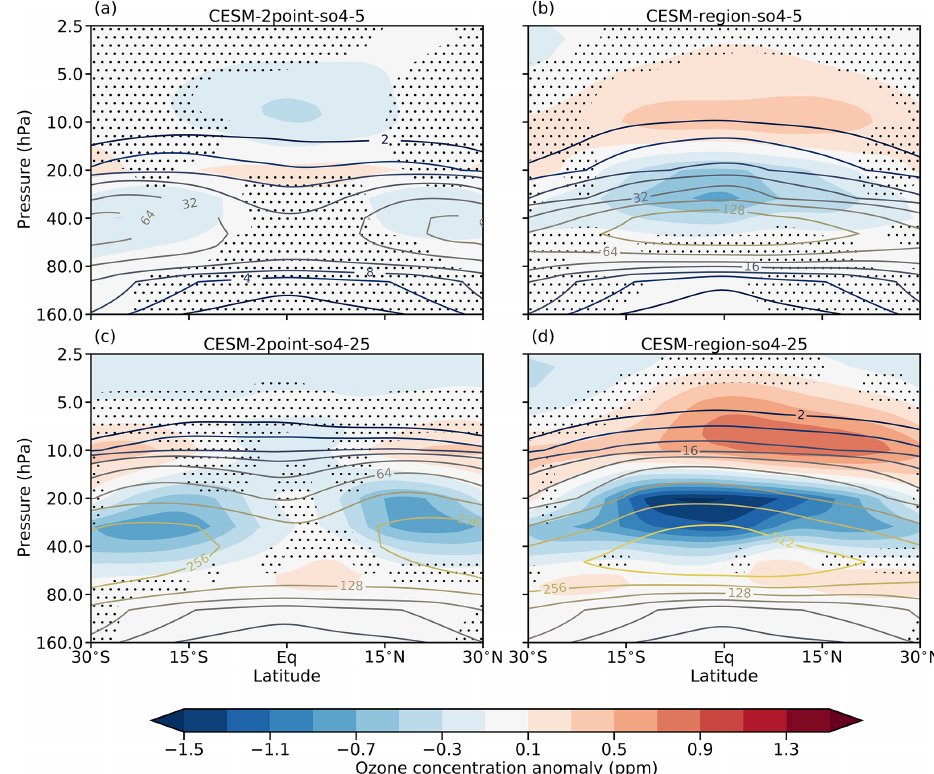
Figure 15. Latitude–height cross section of the ozone concentration anomaly for the simulations of an AM − SO 4 injection in CESM. Stippling indicates regions where anomalies are not significant at the 95% level in Student’s t test. Contour lines indicate the zonal mean in microgram per kilogram (µgkg − 1 ). The contour interval is logarithmic starting at 2µgkg − 1 . The sulfate sulfate mass mixing ratio m SO 4 mass mixing ratio can be reasonably used as a proxy for the heating rate due to absorption of OTLR and